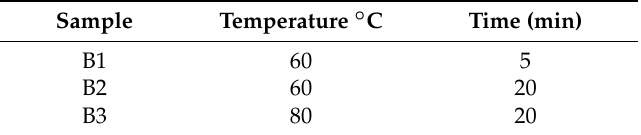
Table 1. Reactions conditions used in method B (power 900 W and frequency 2455